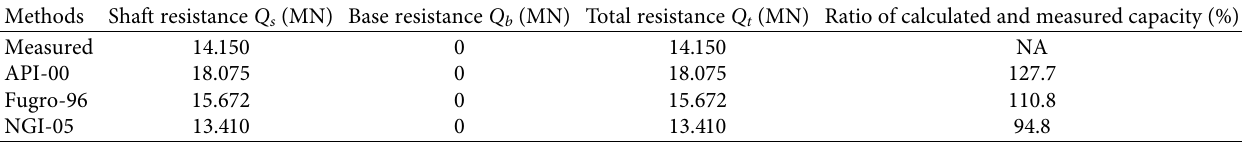
Figure 12: Axial tension load-displacement curves. Table 3: Comparison of measured and calculated results of tension capacity with different design methods.